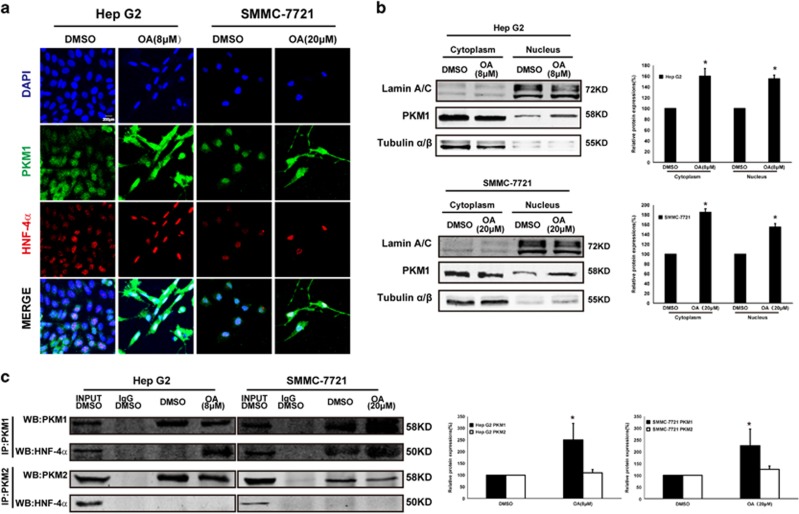
OA enhanced direct interaction between PKM1 and HNF-4α. (a) HepG2 and SMMC-7721 cells were subjected to HNF-4α (red) and PKM1 (green) immunofluorescent staining. Nuclei were stained with DAPI (blue). Magnification, × 400. (b) Nuclear and cytoplasmic fractions were isolated after DMSO or OA treatment for 72 h and subjected to WB for PKM1. Lamin A/C was used as a nuclear control and Tubulin α/β as a cytoplasmic control. (c) DMSO- or OA-treated cells were lysed and PMK1 or PKM2 was immunoprecipitated, respectively. WB assays were performed for HNF-4α, PKM1 and PKM2. Bars, SD. *P<0.05 or **P<0.01 versus DMSO-treated control cells